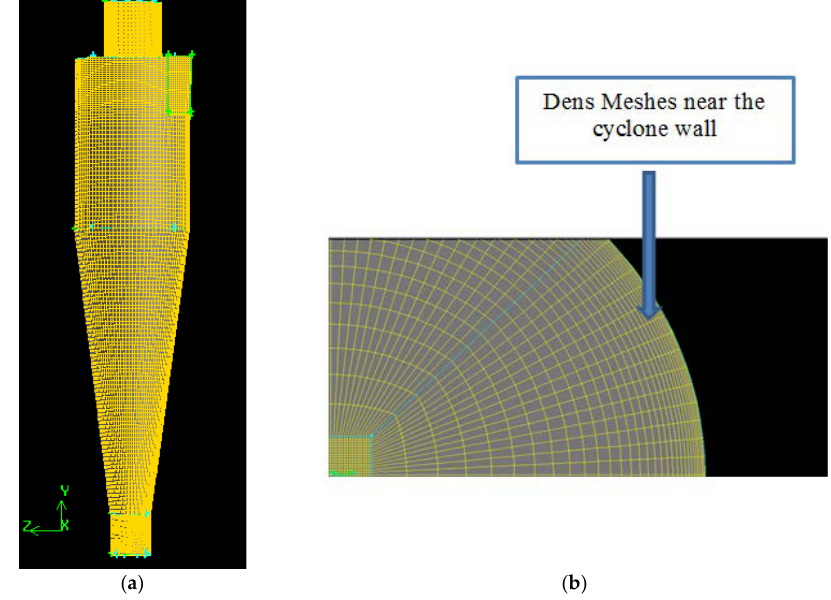
Figure 3. Meshing of cyclone in Gambit: ( a ) Front view, ( b ) top view